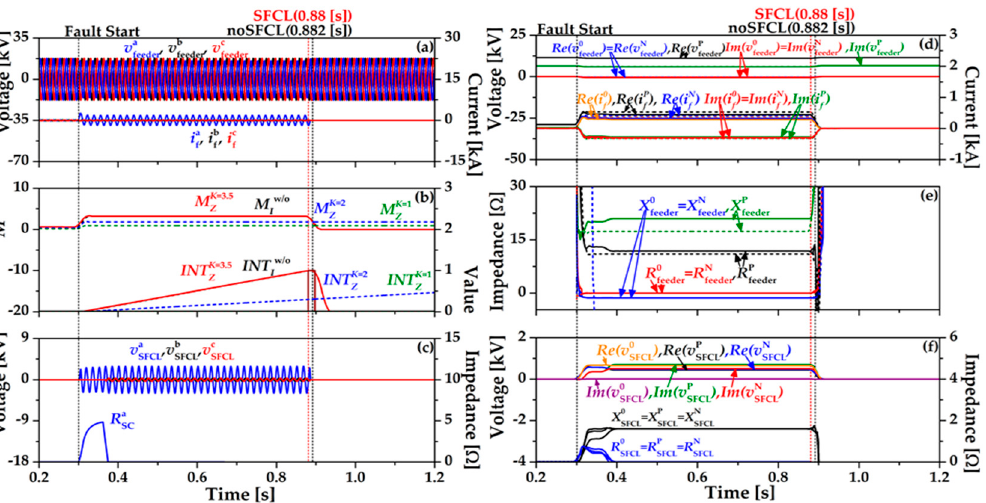
Figure 5. Waveforms and signals of OCR using M I , M Z in SLG. ( a ) Three phase feeder voltage ( v feeder ), current ( i f ). ( b ) Index of CB ( M I , M Z ) and signal of OCR ( INT I , INT Z ). ( c ) Three phase SFCL voltage ( v SFCL ), HTSC element ( R aSC ). ( d ) Sequence feeder voltages ( v 0 feeder , v Pfeeder , v Nfeeder ), sequence feeder currents ( i 0 f , i Pf , i Nf ). ( e ) Sequence feeder impedances ( R 0 feeder , R Pfeeder , R Nfeeder , X 0 feeder , X Pfeeder , X Nfeeder ). ( f ) Sequence SFCL voltages ( v 0 SFCL , v PSFCL , v NSFCL ) and sequence SFCL impedances ( R 0 SFCL , R PSFCL , R N SFCL , X 0 SFCL , X PSFCL , X NSFCL ).